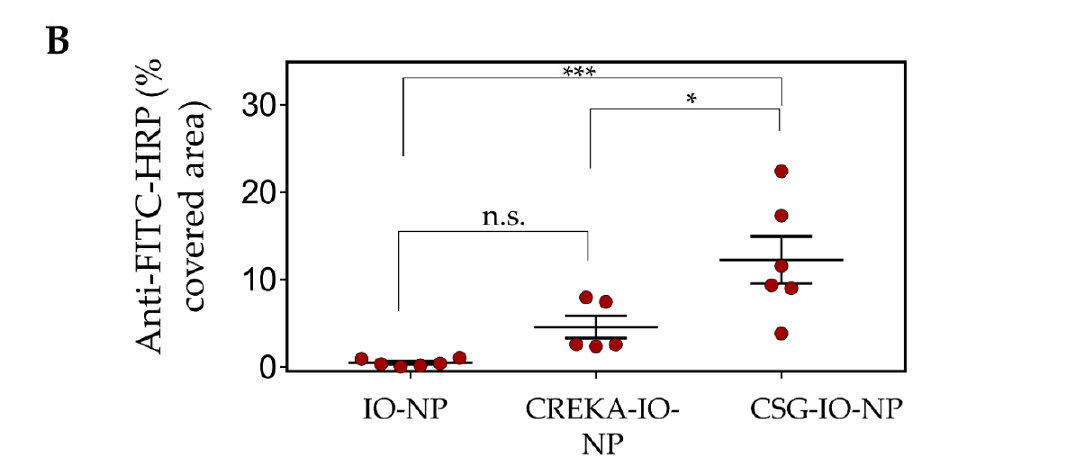
Figure 4. CSG and CREKA deliver IO-NP to a specific target in solid tumours. Mice bearing RIP1-Tag5 tumours were i.v. injected with 100 µ L of the indicated IO-NP (5 mg/kg Fe), and tissues were collected after 4 h of circulation. ( A ) Top: Representative micrographs of tumours (circled, red) with surrounding exocrine pancreas. Nanoparticle uptake in these tissues was detected based on anti-FITC-HRP reactivity (brown) and nuclei were counterstained with haematoxylin. Scale bar, 200 µ m. Bottom: Higher magnification of the tumour area (t) and exocrine pancreas (e). ( B ) Plots of % area per tumour that was positive for anti-FITC antibody detection (in A ) for tumours with untargeted-IO-NP, CREKA-IO-NP and CSG-IO-NP, and mean ± SEM ( n = 3 mice/group *** p < 0.005, * p < 0.05, n.s. = not significant, by one-way ANOVA test).